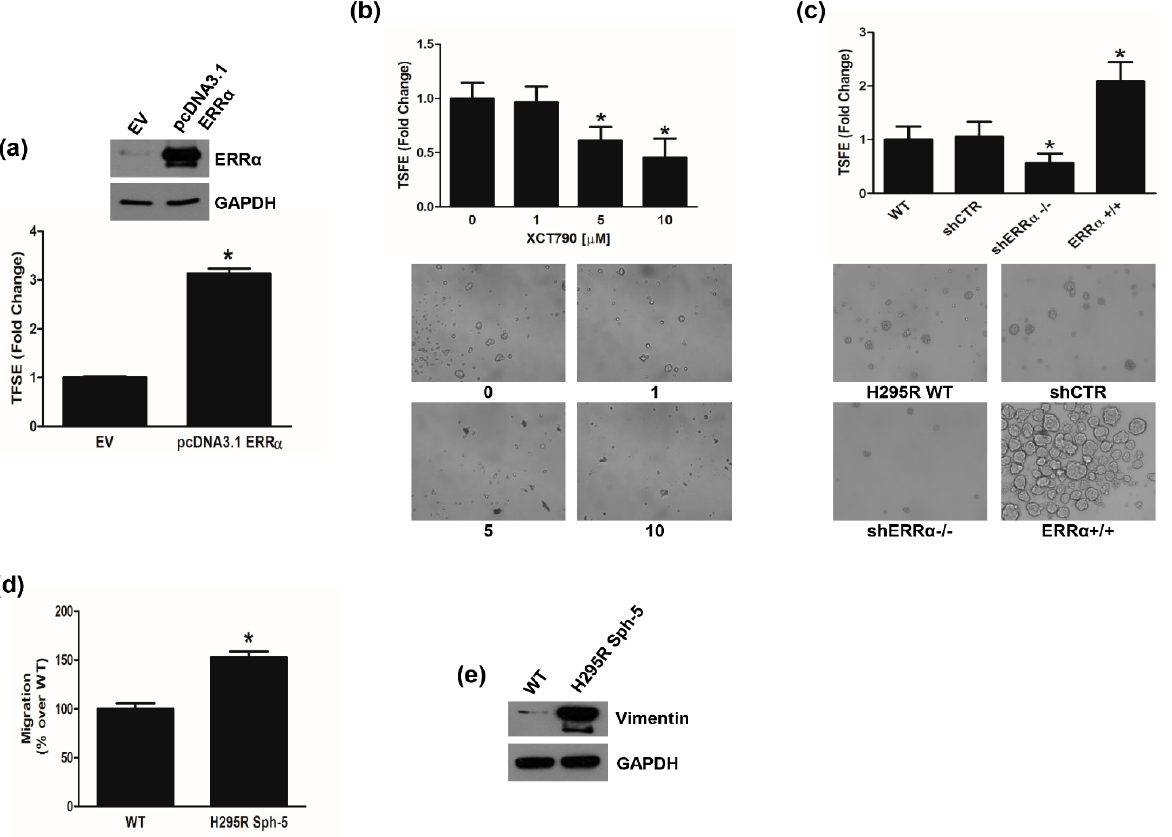
Figure 7. ERR α promotes H295R spheroids formation. ( a ) H295R were transfected for 48 h